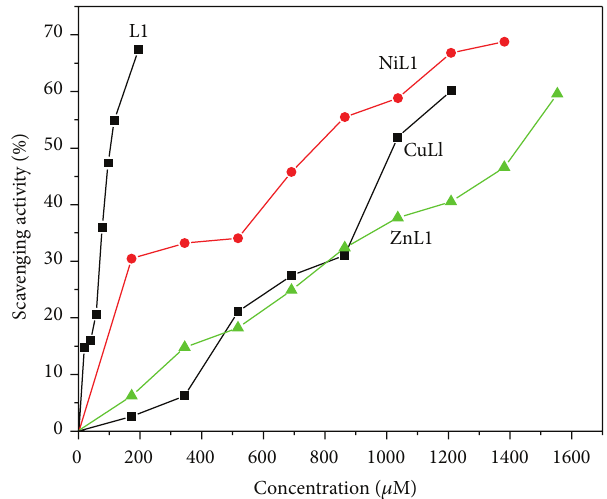
Figure 5: Cyclic voltammogram of CuL at different scan rates: (a) 25 mVs −1 , (b) 50mVs −1 , (c) 75 mVs −1 , (d) 100 mVs −1 , and (e) 125 mVs −1 . Figure 6: Scavenging activity of the ligand (L) and its Cu(II), Ni(II), and Zn(II) complexes at various